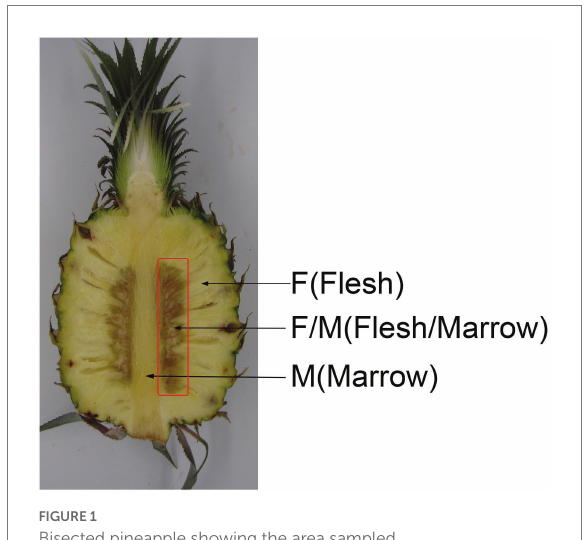
FIGURE 1 Bisected pineapple showing the area